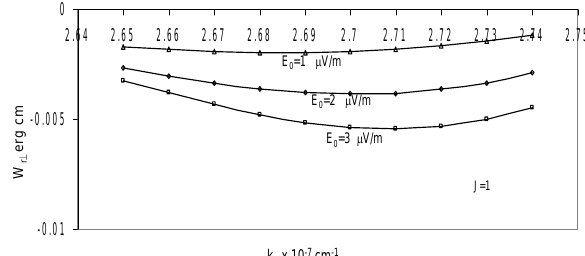
Fig. 4. Variation of growth rate ( γ / (cid:127) i ) versus wave vector k II Fig. 7. Variation of perpendicular resonant energy Wr ⊥ ergcm Fig. 7 Variation of perpendicular resonant energy Wr ⊥ ergs-cm versus wave vector k II cm-1 for different Fig:-4 Variation of perpendicular resonant energy W r ⊥ ergcm versus wave vector k II cm -1 for different values of parallel Ω ) versus wave vector k i electric field E 0 ,and distribution index J=0. cm − 1 for different values of parallel electric field E 0 , and distribu- Fig:-1 Variation of growth rate( γ / Ω ) versus ve vector k cm -1 for different values of parallel electric field E 0 ,and distributio i Fig. 4 Variation of growth rate ( γ / versus wave vector k II cm − 1 for different values of parallel electric values of parallel electric field E 0 , and distribution index J = 0 II cm-1 for different values of parallel electric field E 0 , and distribution index J=0. tion index J=0. field E 0 , and distribution index J=0.